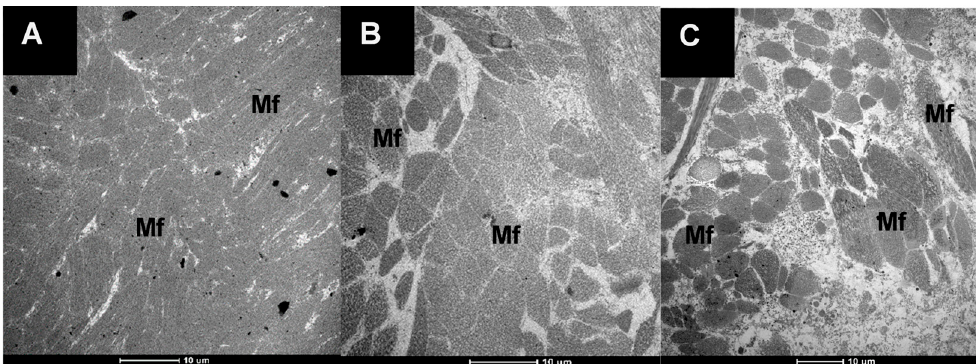
Figure 6. Transmission electron micrographs of the muscle tissues of p ā ua that were canned and cooked in a water retort at 116 °C for 30 min. ( A ) untreated (control), ( B ) ultrasonicated in water for 5 min followed by soaking for 24 h, and ( C ) ultrasonicated in 1% actinidin solution for 5 min; (Mf) myofibrils.